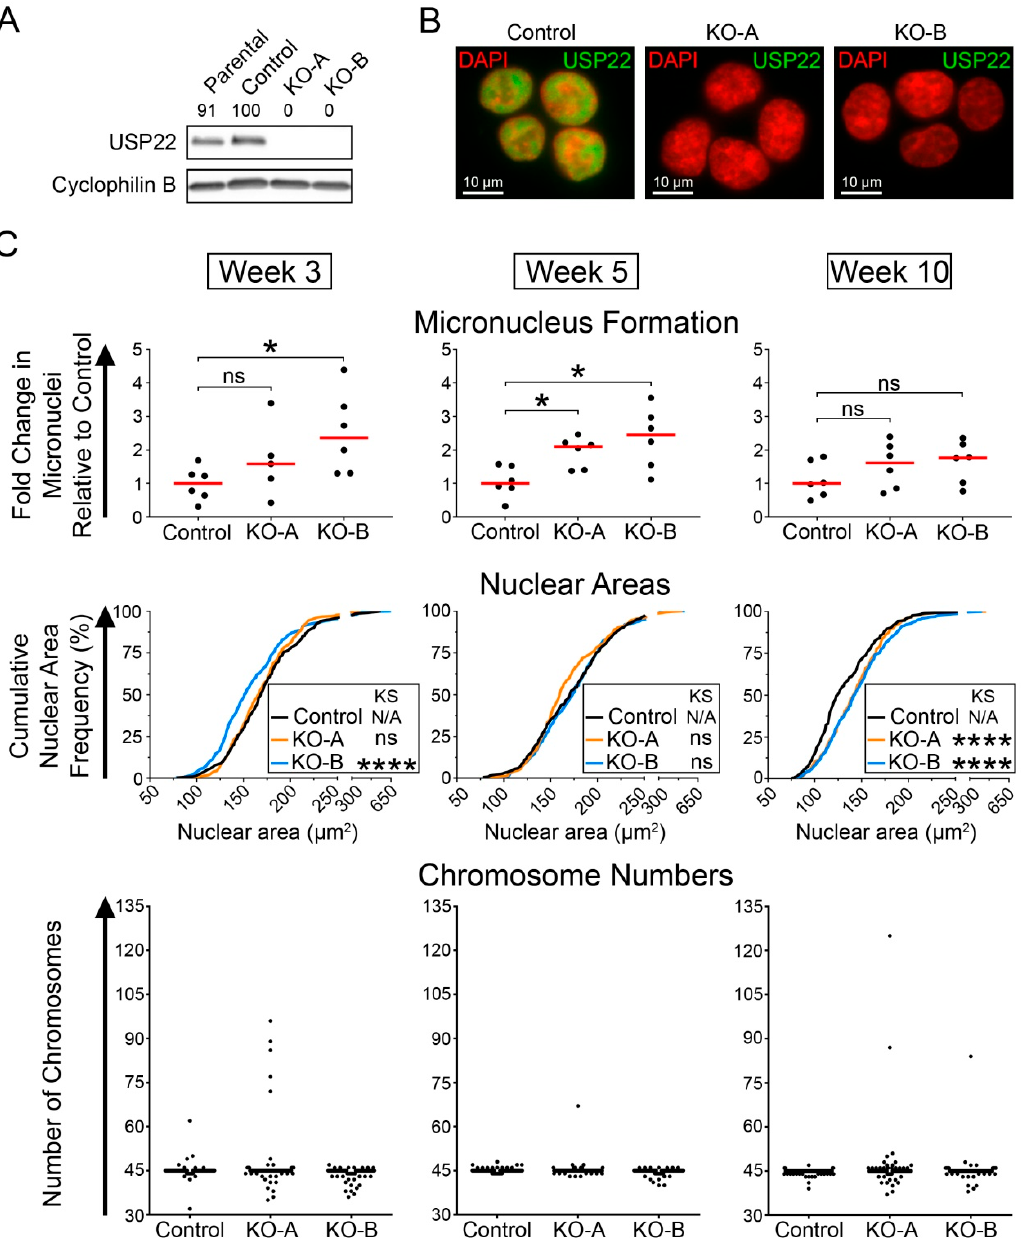
Figure 6. USP22 -KO cells exhibit dynamic changes in nuclear areas, micronucleus formation and chromosome numbers. ( A ) Western blot presenting USP22 expression levels in Parental HCT116, Control and USP22 -KO-A and -B; cyclophilin B serves as the loading control. Semi-quantitative analyses were performed and the normalized USP22 levels are presented relative to the Control (100%). ( B ) High-resolution images of Control, KO-A and KO-B cells, immunofluorescently labeled for USP22 and counterstained with DAPI. For quantitative comparisons, all images were acquired using identical exposure times. ( C ) Changes in CIN phenotypes in USP22 -KOs at three distinct time points (indicated at top). Dot plots presenting the fold change in micronucleus formation relative to the median of the Control at the indicated time points (top row). Mann–Whitney tests reveal significant changes in micronucleus formation relative to the Control (minimum 100 nuclei analyzed/replicate; ns p -value > 0.05; * p -value < 0.05). Cumulative nuclear area distribution frequencies of Control, USP22 -KO-A and USP22 -KO-B (middle row) reveal dynamic changes in nuclear areas in the USP22- KO clones relative to Control over time (300 nuclei analyzed/replicate; N/A not applicable; ns p -value > 0.01; **** p -value < 0.0001). Dot plot (bottom row) presenting the number of chromosomes enumerated from 100 mitotic chromosome spreads/condition.